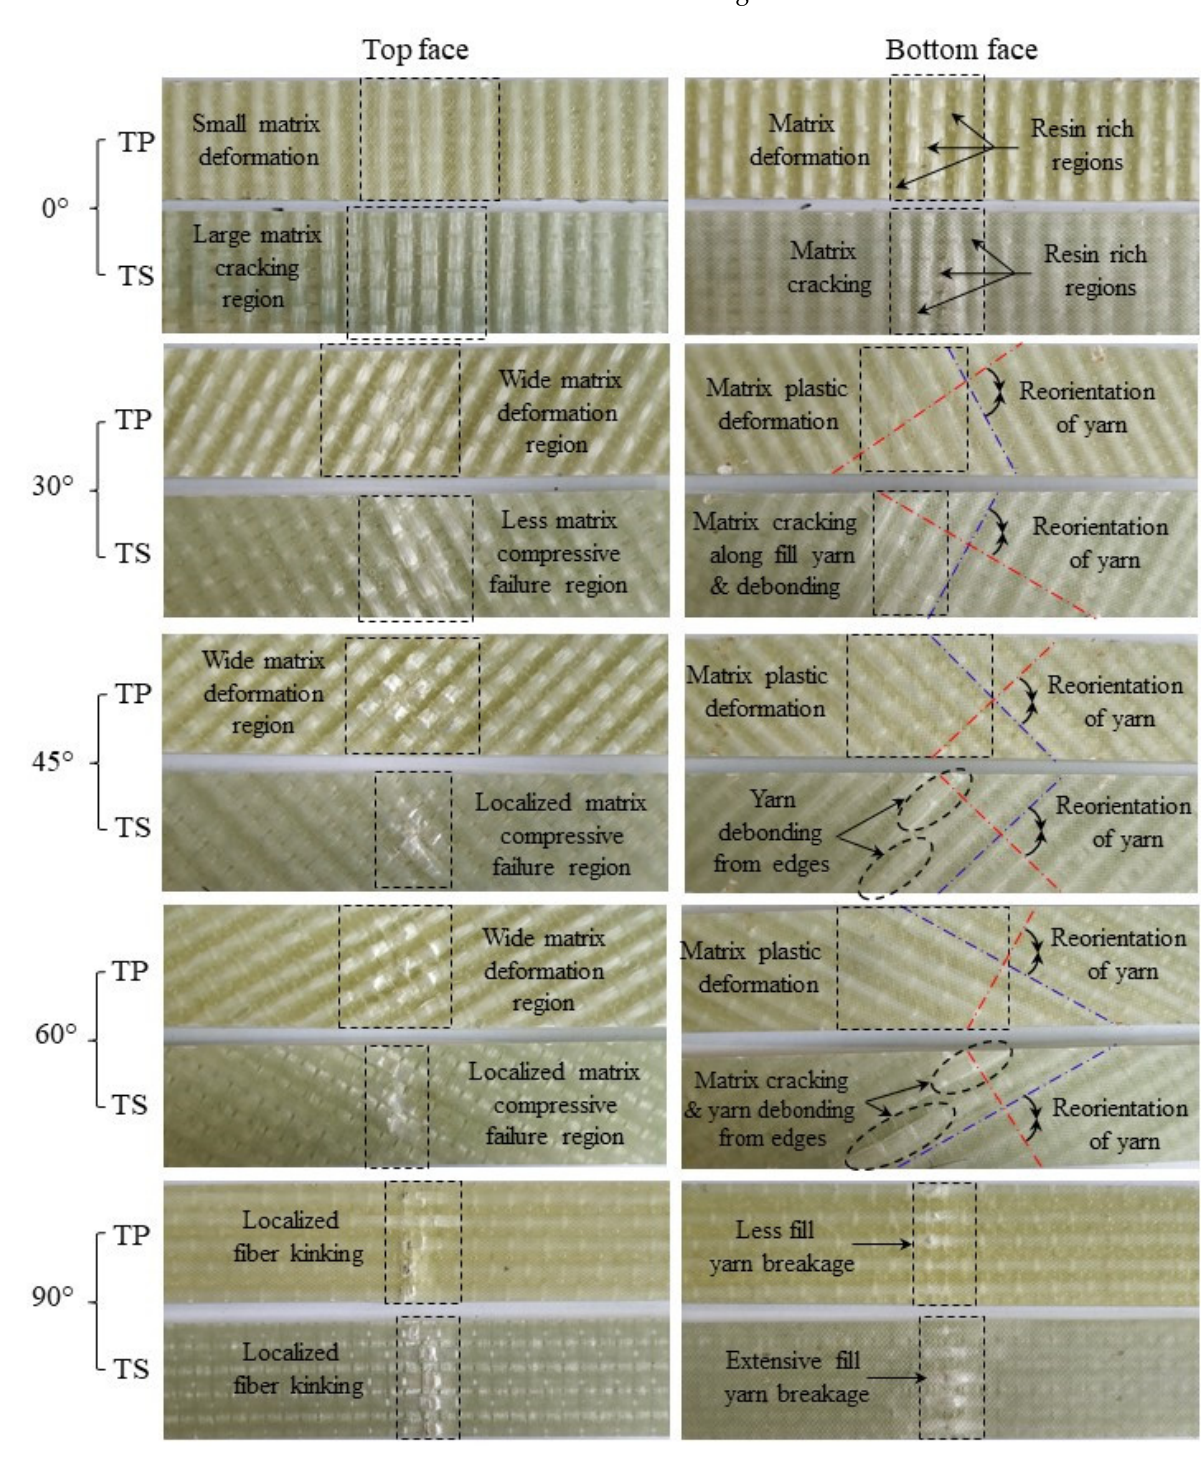
Figure 8. Comparison of macroscopic damage patterns in 3D-FRC. Blue-line represents fill yarn, and the red line represents warp yarn.